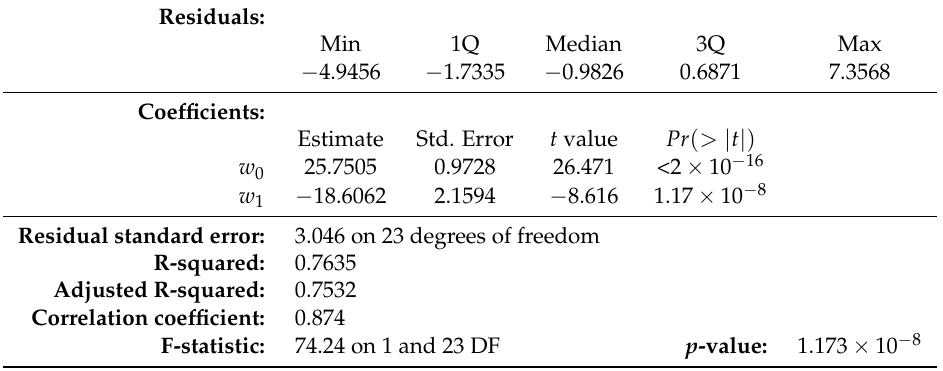
Table 3. Analysis of the linear regression model of the proposed surrogate